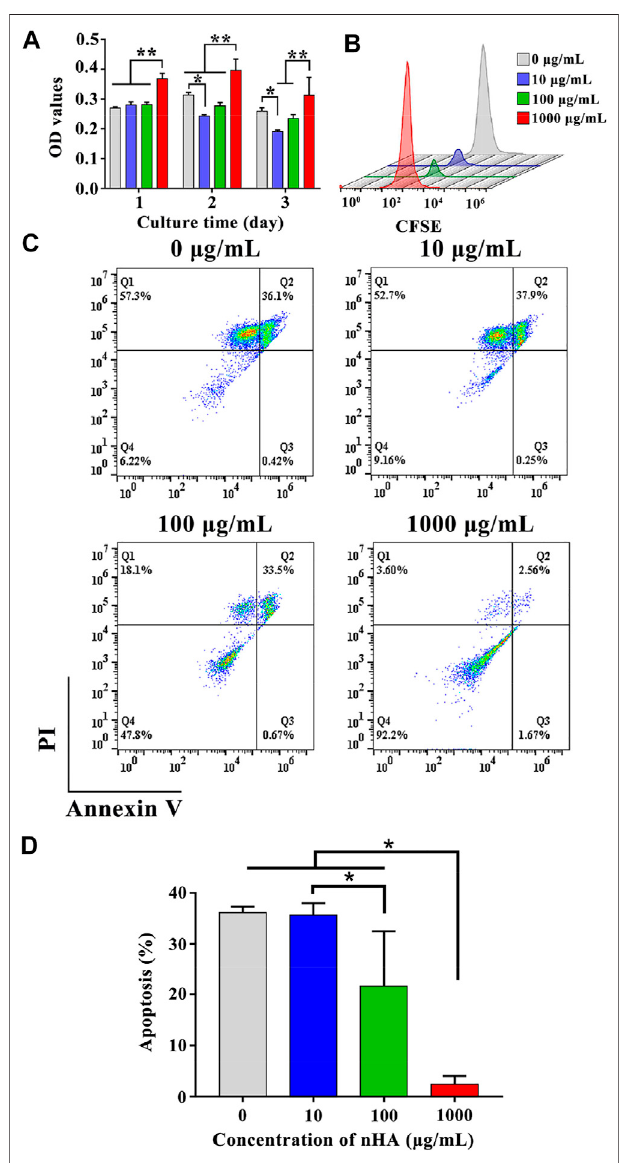
FIGURE 3 | (A) T cells viability on various samples for 1, 2 and 3 days. * represents p < 0.05 and ** represents p < 0.01. (B) Effect of nHA on T cell proliferation. (C) Flow cytometry analysis of the effect of nHA on T cell apoptosis. (D) Quantitative analysis of apoptosis.